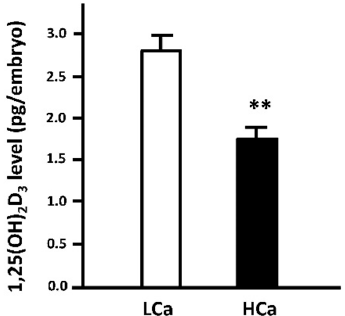
Figure 2. Effect of environmental Ca 2+ concentrations on whole-body 1,25-dihydroxyvitamin D 3 (1,25(OH) 2 D 3 ) content in 3 day post-fertilization (dpf) zebrafish embryos. One to two cell-stage zebrafish embryos were incubated in low- (0.02 mM Ca 2+ ) and high-Ca 2+ (2.0 mM Ca 2+ ) water, respectively, for three days. The low-Ca 2+ (LCa) group showed a higher level of 1,25(OH) 2 D 3 than the high-Ca 2+ (HCa) group. Whole-body 1,25(OH) 2 D 3 content was measured with an ELISA kit (E0467GE, EIAlab, Wuhan, China). Values are the mean ± SEM ( n = 5). Student’s t -test, ** p < 0.01.